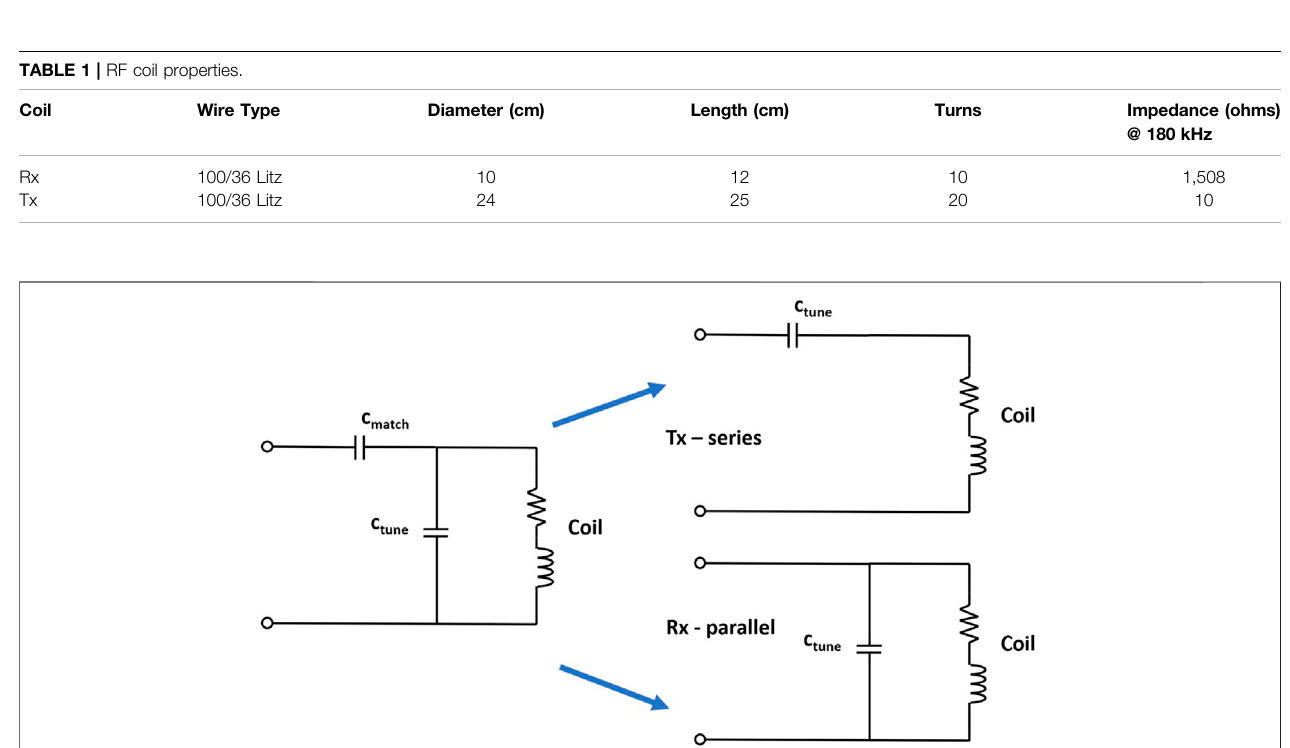
FIGURE 2 | RCL circuit. Typical tuning of the RF coil uses a tuning capacitor in parallel ( c tune ) and a matching capacitor in series ( c match ). In the low- fi eld design, Tx can be tuned in series, providing minimum impedance, and Rx can be tuned in parallel, providing a higher Q.